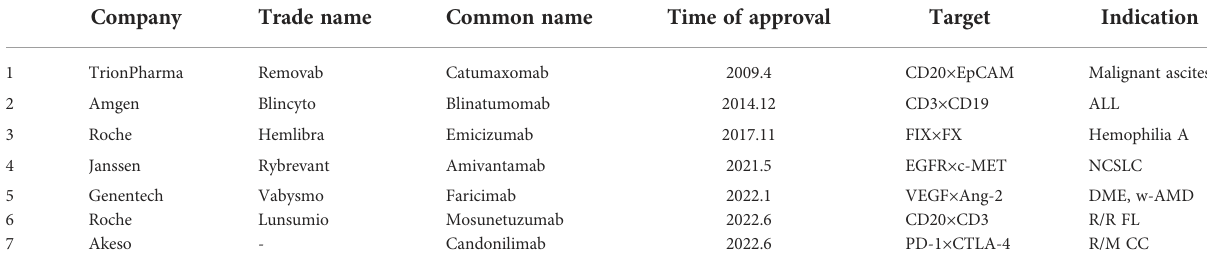
TABLE 2 BsAbs that have been on the